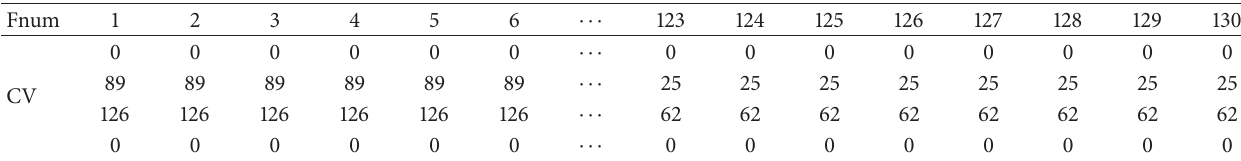
Table 3: Clustering vectors of 130